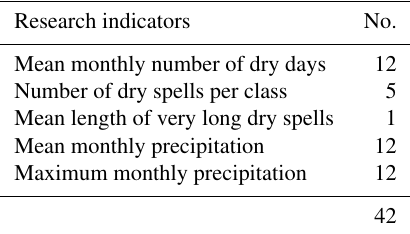
Table 3. Overview of the considered research